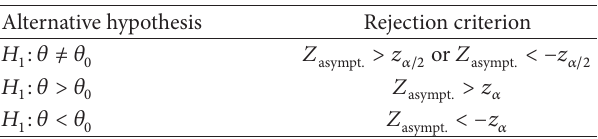
Alternative hypothesis Rejection